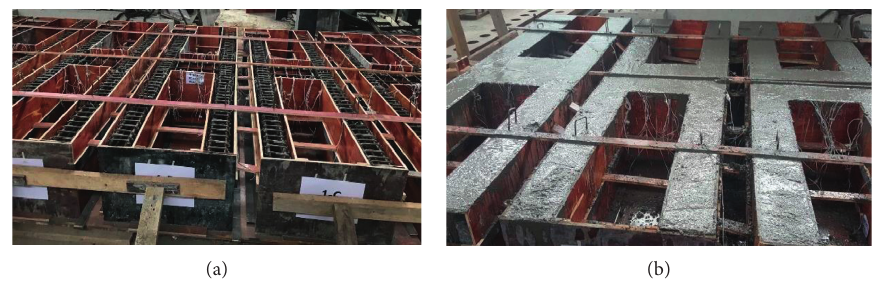
Figure 5: Making specimens. (a) Making models. (b) Pouring concrete. Table 2: Mechanical properties of concrete.